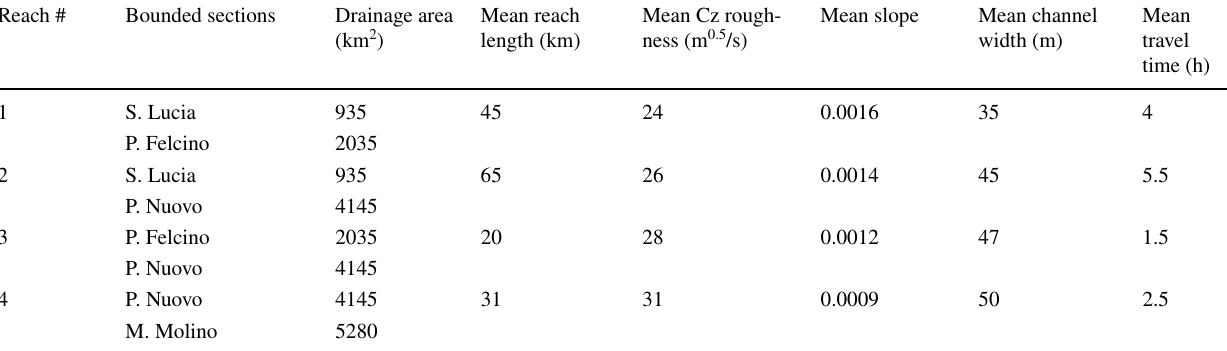
Table 1 Main characteristics of river reaches. Sources: Moramarco et al (2005), Tayfur et al (2007), Tayfur and Moramarco (2008), Tayfur et al (2009), Zucco et al (2015)